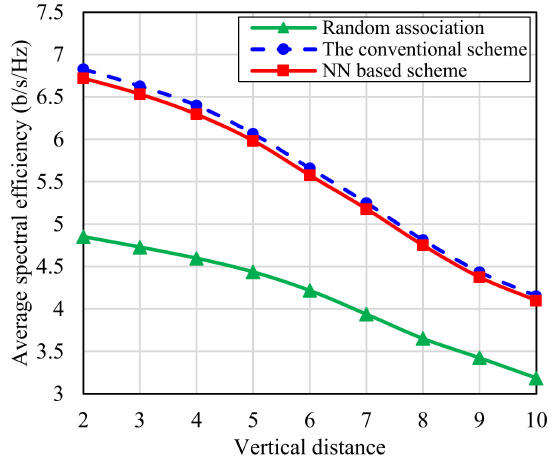
Figure 12. The average system spectral efficiency against vertical distance between IRSs plane and UEs plane.